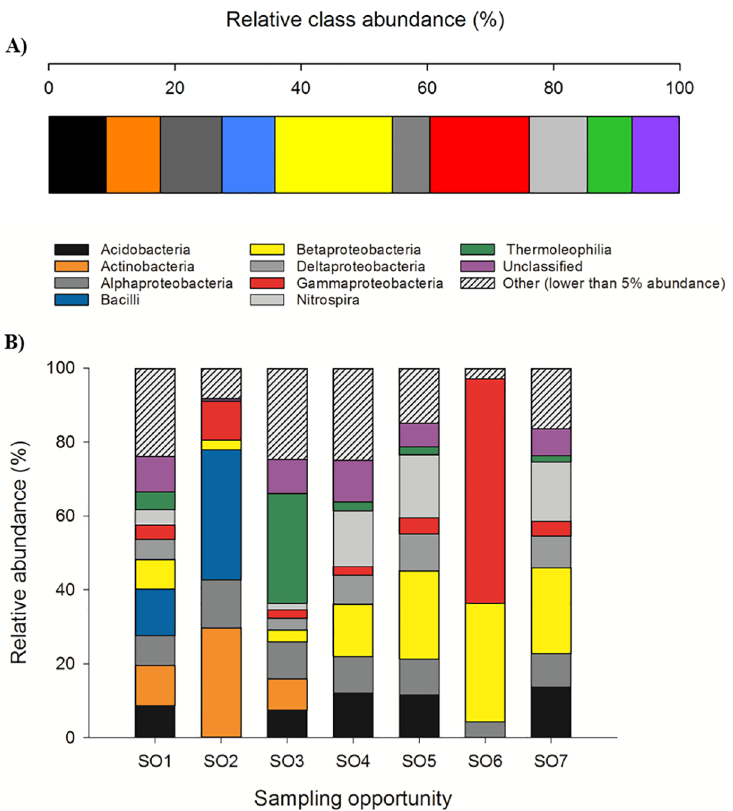
Fig 5. Relative class abundance of A) the whole cave and B) separatedinto the different sampling sites. Phylogenetic groupsaccountingfor (cid:20) 5% of all classified sequencesare summarizedin the artificial group “others” (Part B). Full relative class abundance is given in Supplementary Table